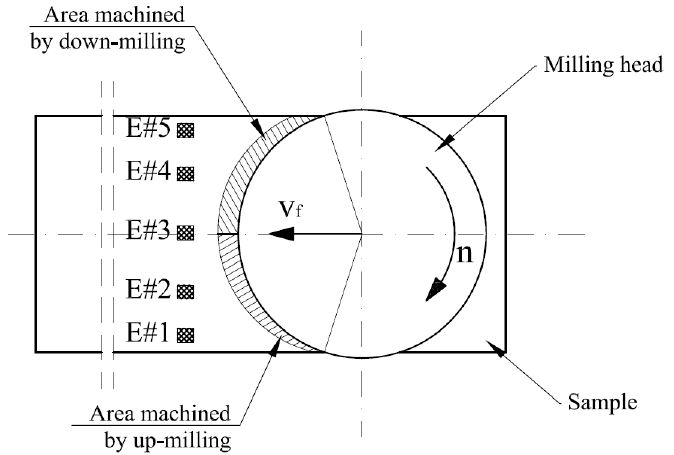
Figure 4. Location of surface topography measurement areas on the sample width, where E#1, E#2, E#3, E#4 and E#5 are names of measurement areas; v f —feed velocity (mm · min − 1 ); n —rotational speed (min − 1 ).